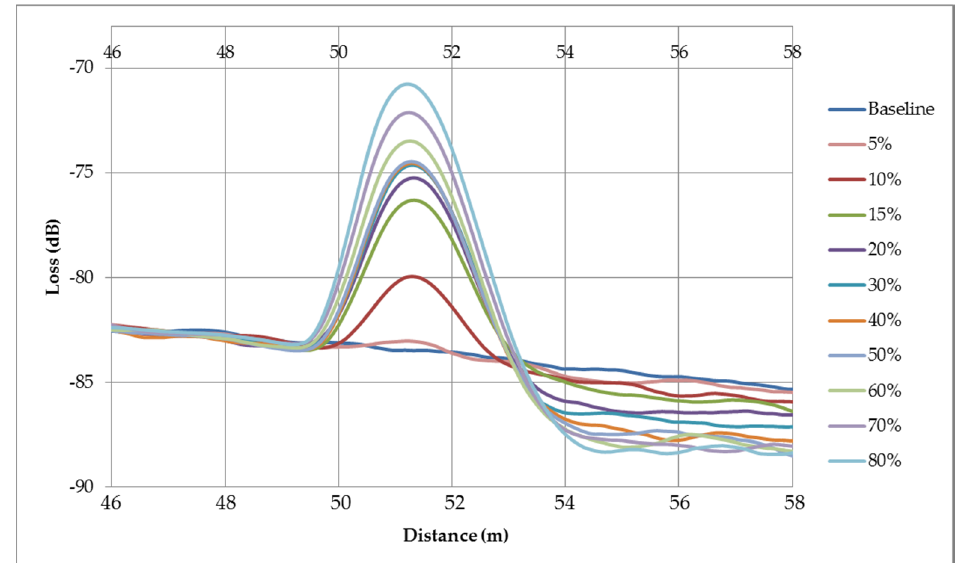
Figure 17. OTDR signal at high strain intervals from 5% to 80% strain.